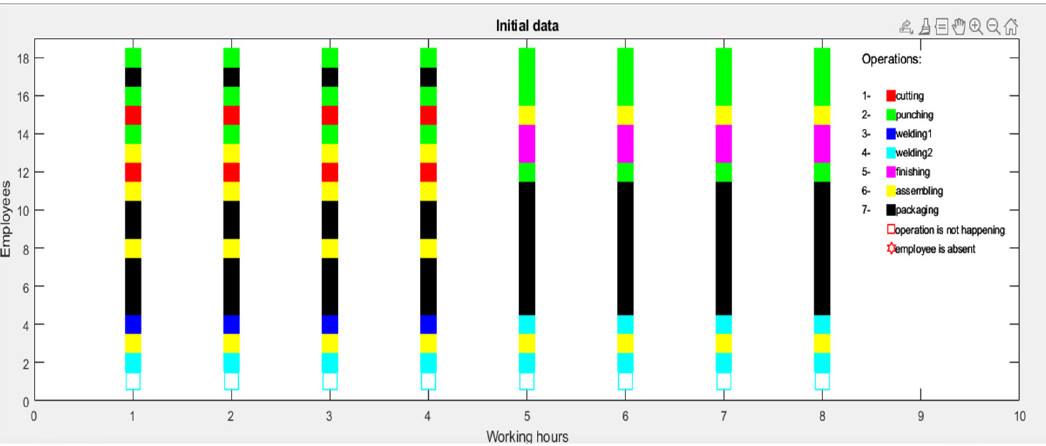
Figure 6. Initial data, 1st case.